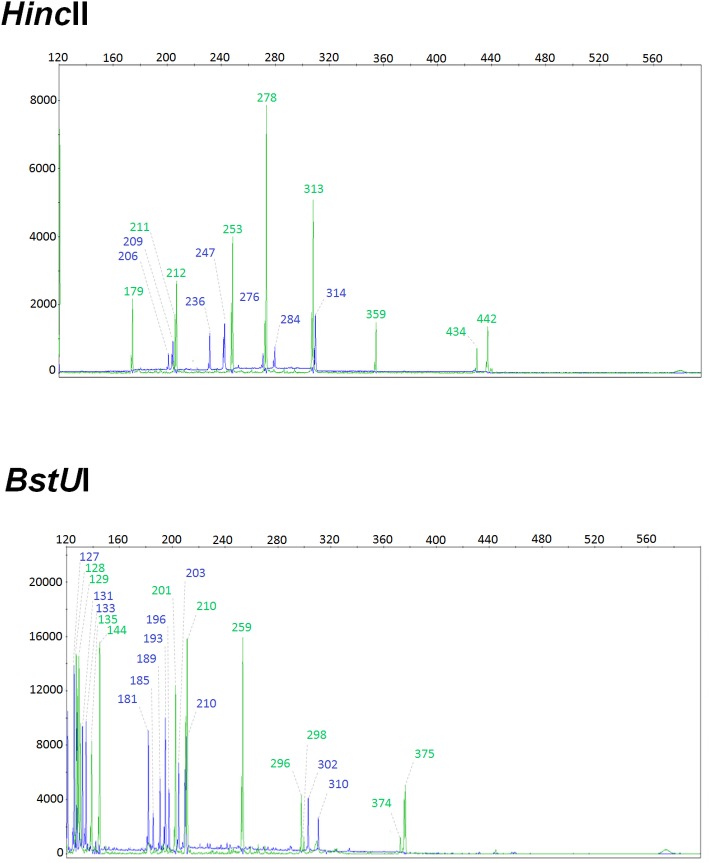
IS6110-5’3’FP chromatograms of the 11-banded laboratory reference strain using the original (HincII-based) and the optimized version developed herein (BstUI-based).x-axis = fragments size in base pairs (bp); y-axis = fluorescence intensity in relative fluorescence units (RFU).